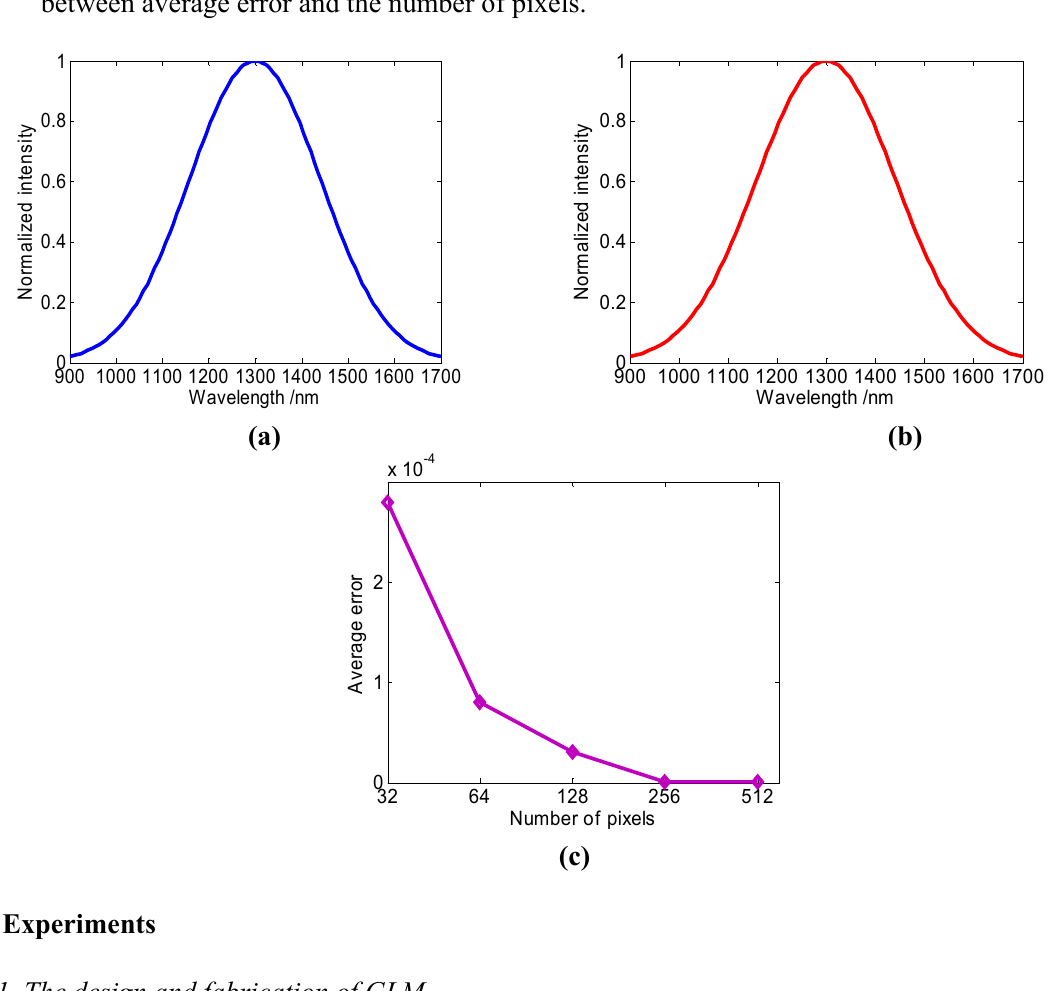
Figure 5 . (a) Original spectrum (b) Reconstructed spectrum by 512 pixels (c) Relationship between average error and the number of